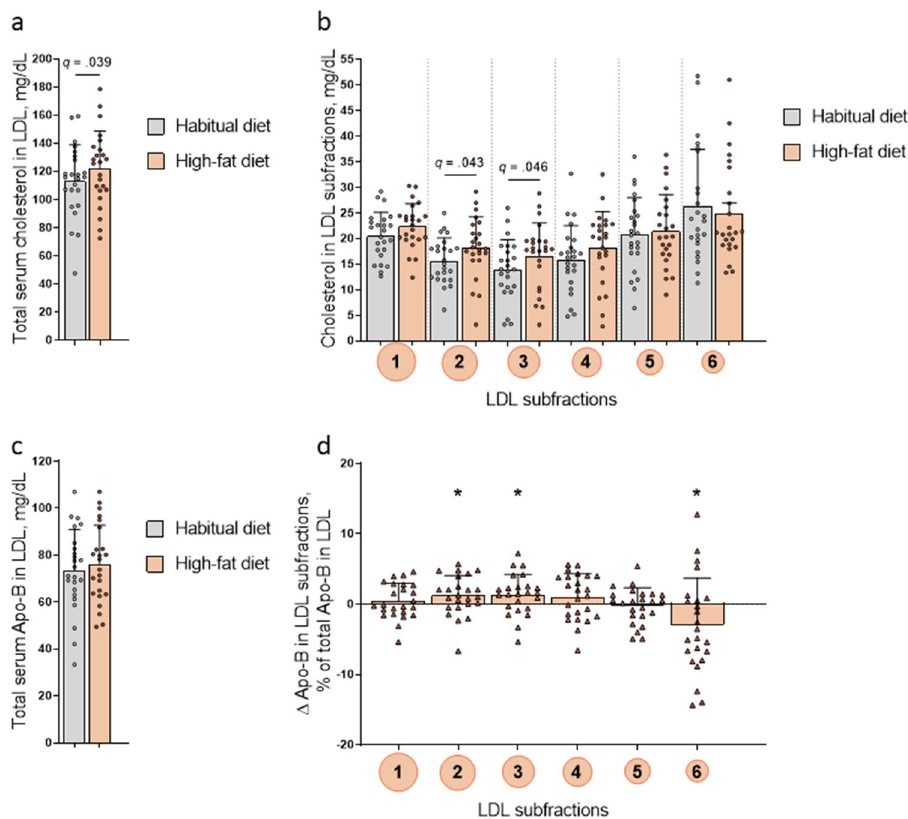
Figure 4. Cholesterol and Apolipoprotein-B100 (Apo-B) in LDL measured in the fasted state. Data from participants ( n = 24) before (habitual diet) and after 5 days of high-fat diet. ( a ) Total serum cholesterol, ( b ) Cholesterol in LDL subfraction 1–6, ( c ) Total serum Apo-B, ( d ) Change in Apo-B in LDL subfraction 1–6, as percentage of total Apo-B in LDL, after 5 days of high-fat diet. Bars show means, error bars are SD, and symbols show individual values. * p <